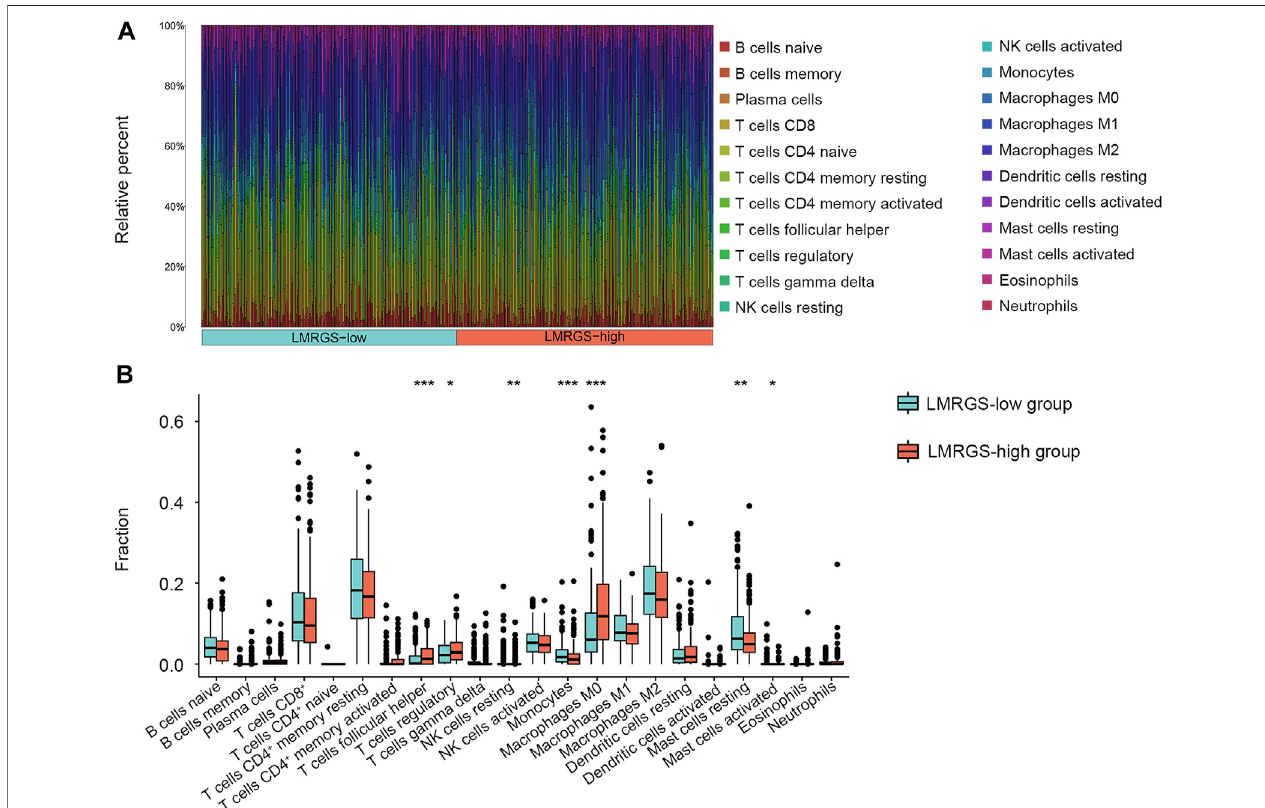
FIGURE 8 | Features of immune cell in fi ltrate in different LMRGS subgroups. (A) The heatmap displayed the proportion of immune cell in fi ltration in each HCC sample. (B) Differences in immune cell in fi ltration between LMRGS-low and LMRGS-high groups. * p < 0.05, ** p < 0.01, *** p < 0.001.